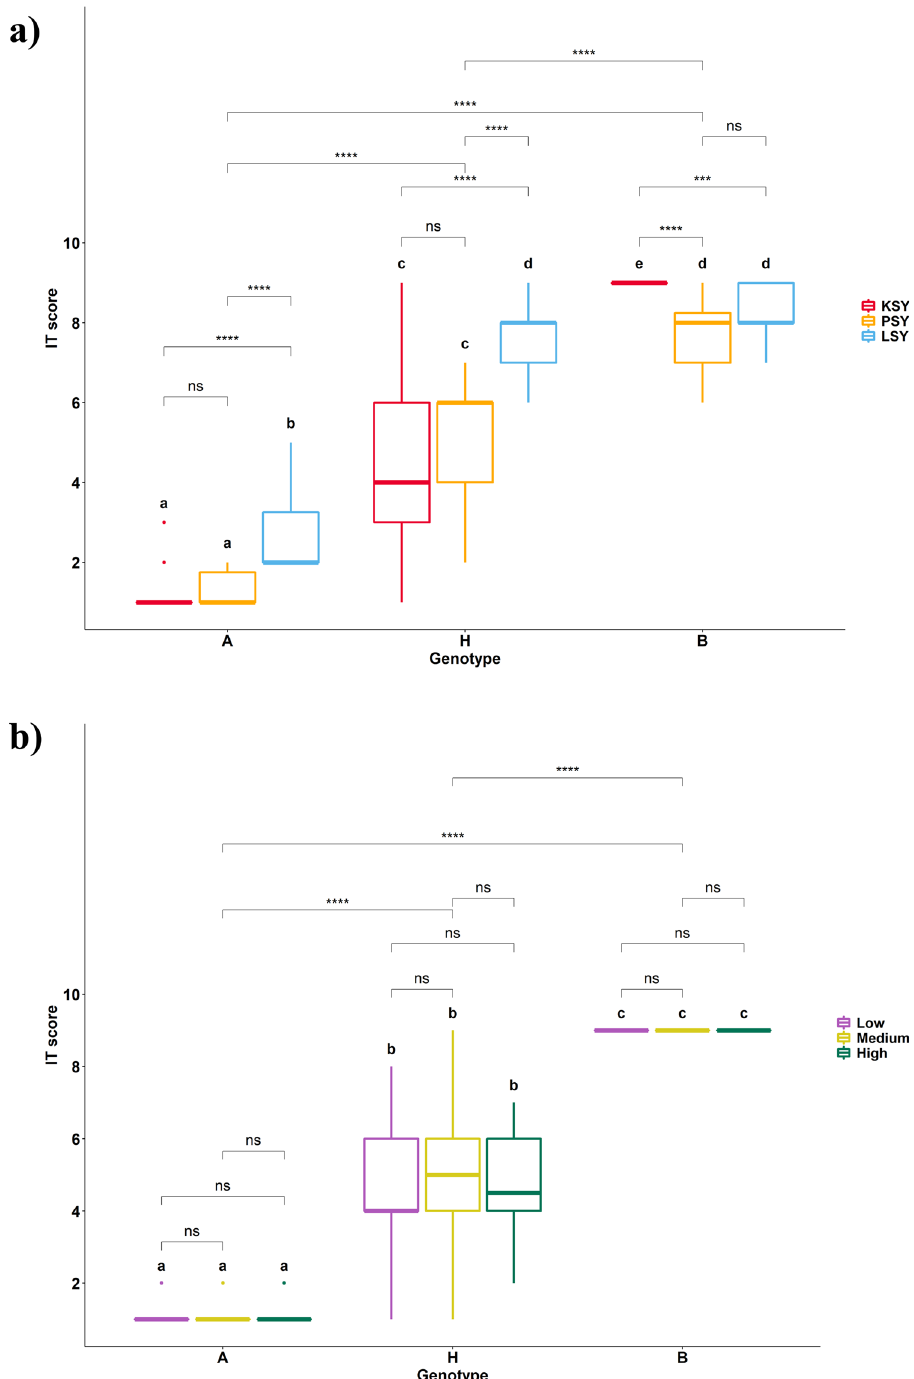
Fig. 4 Boxplots of IT score and results of multiple means comparison using the Tukey – Kramer post hoc test between genotypes A , H and B . a Analysis for three Yr84 populations and b for three treatments of KSY population with low, medium, and high Pst spore concentrations. Population codes are as following: KSY – PI 487260× Kronos; PSY – KSY_10-64( Yr84 carrier) × CDC Precision; LSY – RSY_2-2-1-2( Yr84 carrier) × CDC Landmark. Boxplot shows the median (middle quartile), interquartile range (IQR) from 25th to the 75th percentile, “ minimum ” whisker as Q1 – 1.5*IQR and “ maximum ” whisker as Q3 + 1.5*IQR. Letters under each boxplot represent signi fi cantly different groups of IT score (two tailed; p < 0.05). Signi fi cance codes: **** <